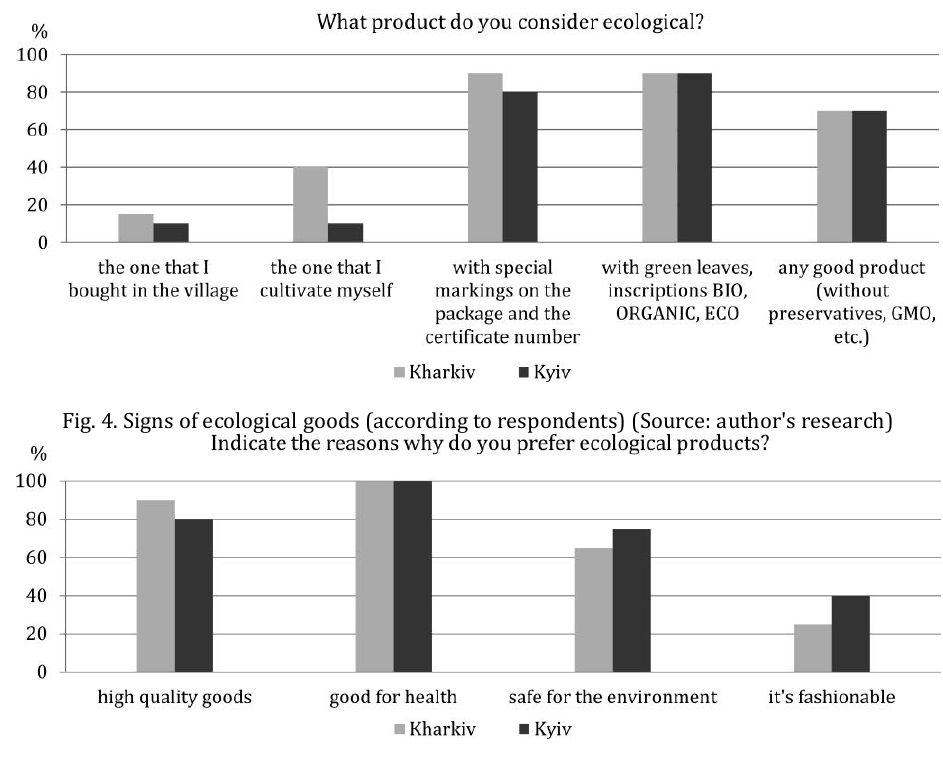
Fig. 5. Motives for choosing ecological products (Source: author's